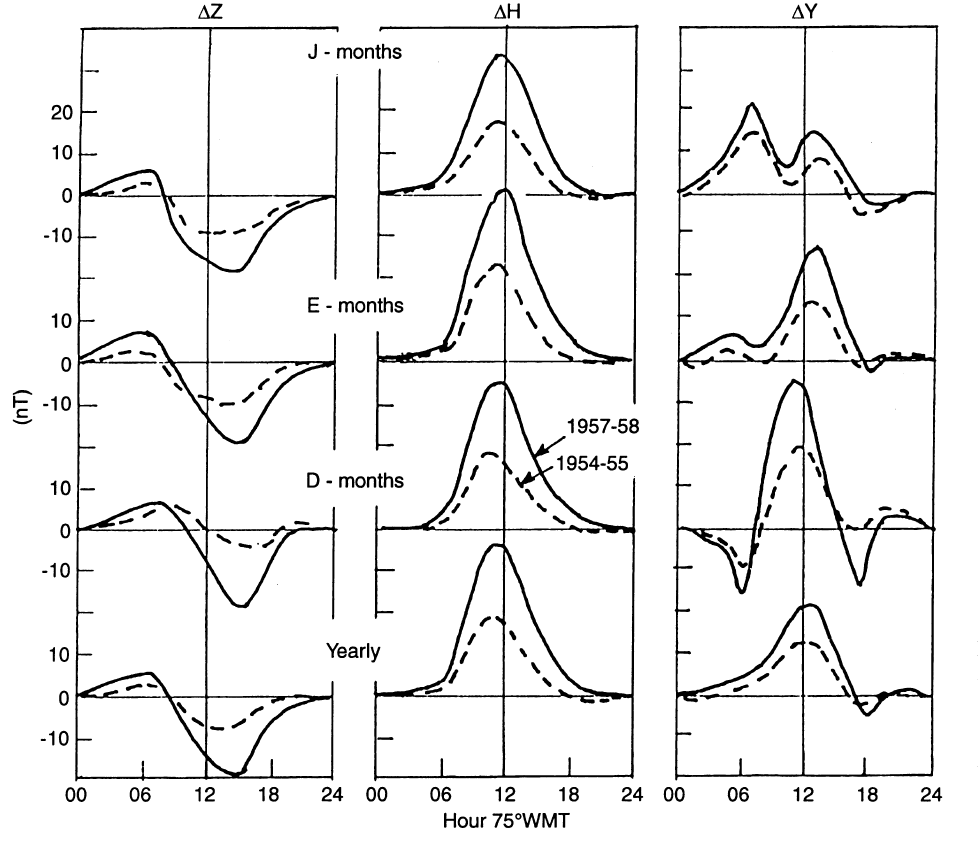
Fig. 2. Solar daily variations of H , Y and Z fields at Huancayo averaged for di(cid:128)erent Lloyd seasons of low sunspot